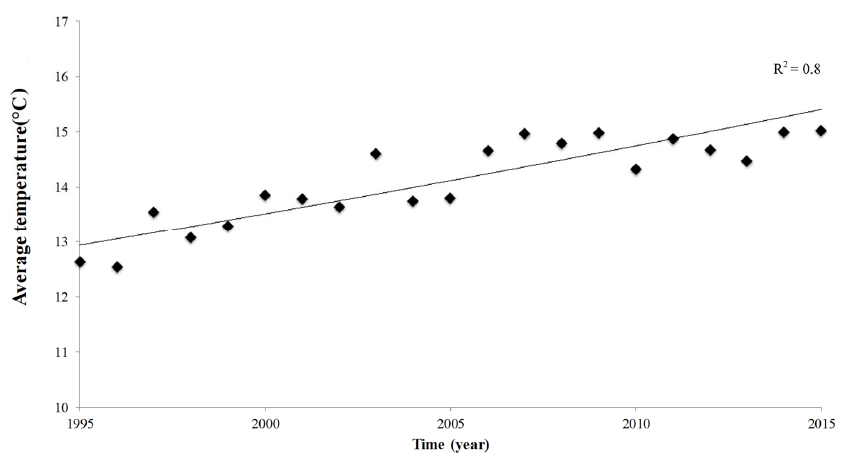
Figure 2. Annual average temperature (°C) in the grape ‐ wine growing area PDO ‘Orvieto’ (1995– 2015).